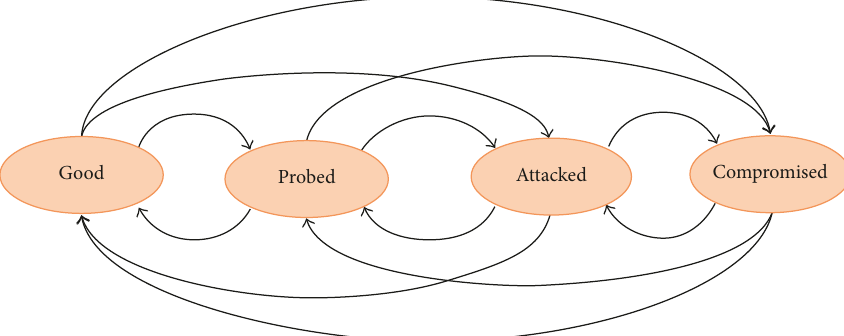
Figure 4: Hidden Markov model